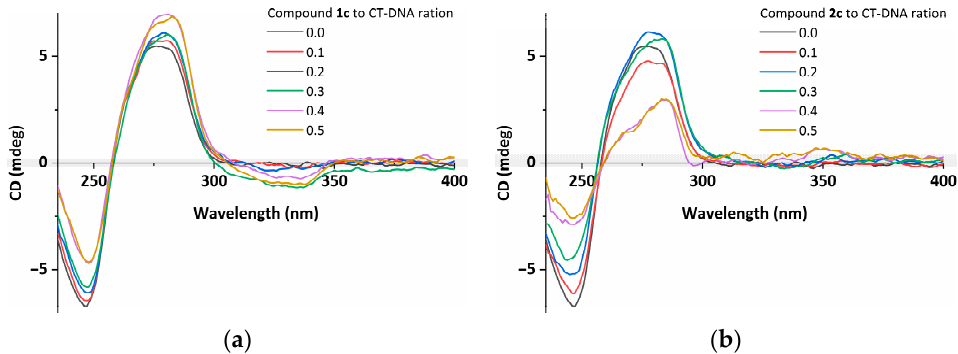
Figure 8. ( a ) Circular dichroism spectra of CT-DNA (6.0 × 10 − 4 mol/L) in the presence or absence of compound 1a in Tris-HCl buffer (pH 7.2) at 20 °C. ( b ) Circular dichroism spectra of CT-DNA (6.0 × 10 − 4 mol/L) in the presence or absence of compound 2c in Tris-HCl buffer (pH 7.2), at 20 °C.